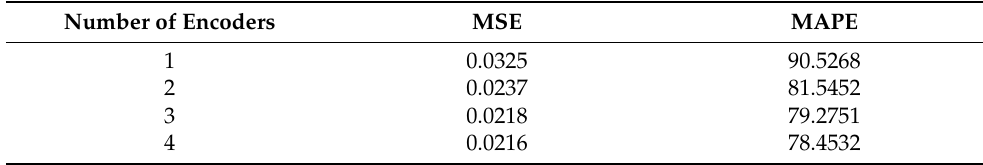
Table 2. Effect of the number of encoders on the results.